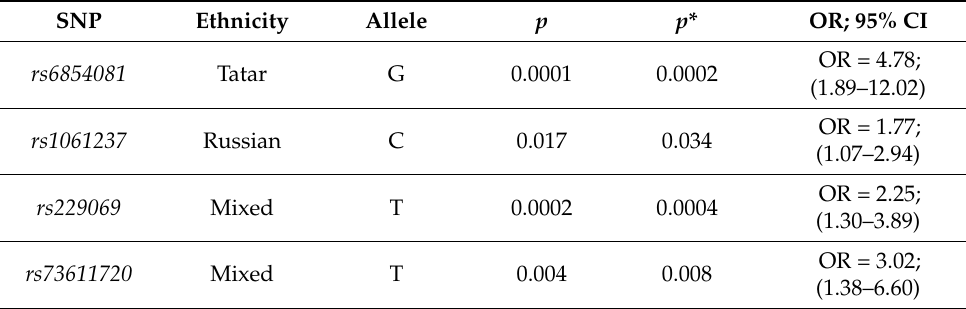
Table 4. Associations of the miRNA target sites loci in different ethnic